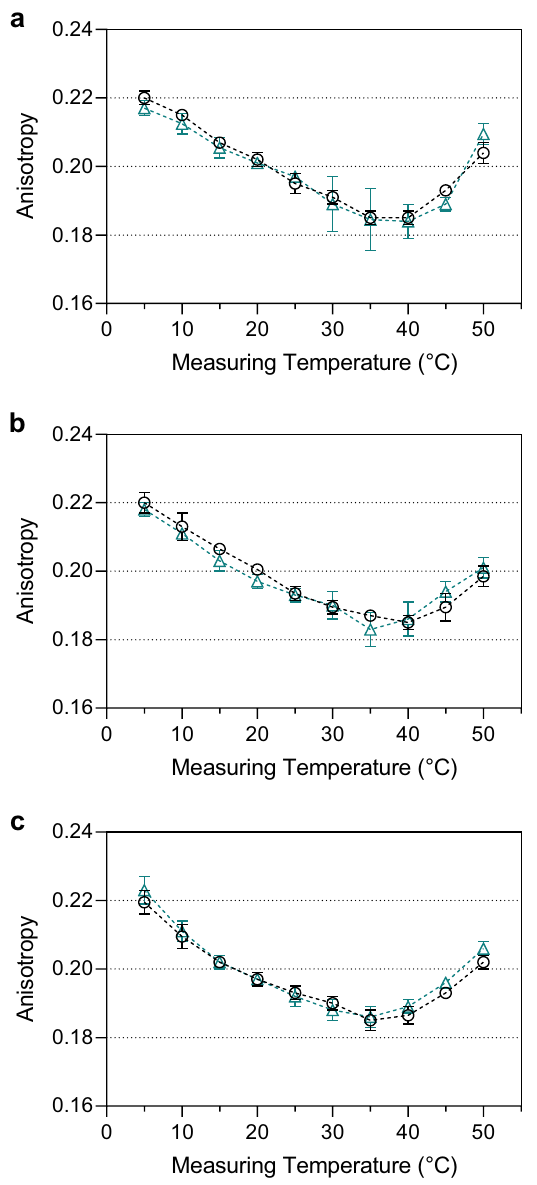
Figure 3. Time-dependent analysis of membrane fluidity by TMA-DPH anisotropy. Listeria monocytogenes strain DSM 20600 T incubated at 6 °C after 1 h ( a ), 24 h ( b ), and 48 h ( b ) in Ringer’s solution without supplementation (black circles) and with 0.1% (wt/vol) of polysorbate 80 (green triangles). Values are means ± standard deviation ( n =